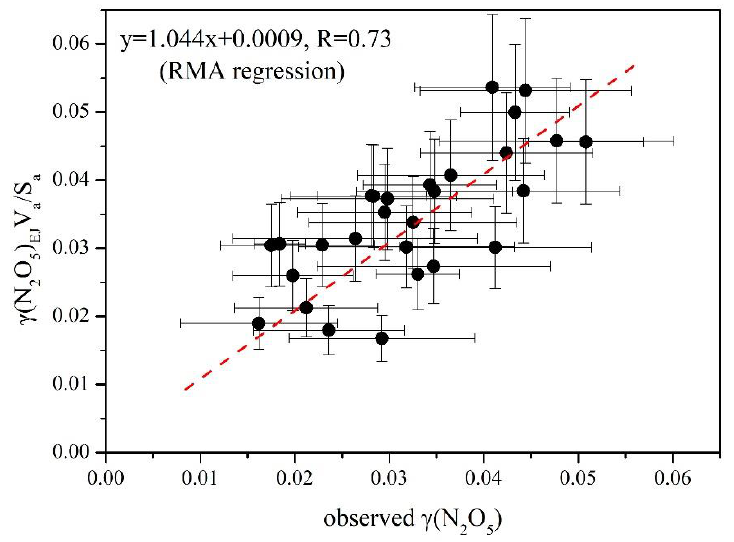
Figure 7. Scatter plot of γ(N 2 O 5 ) EJ V a /S a and the observed γ(N 2 O 5 ).